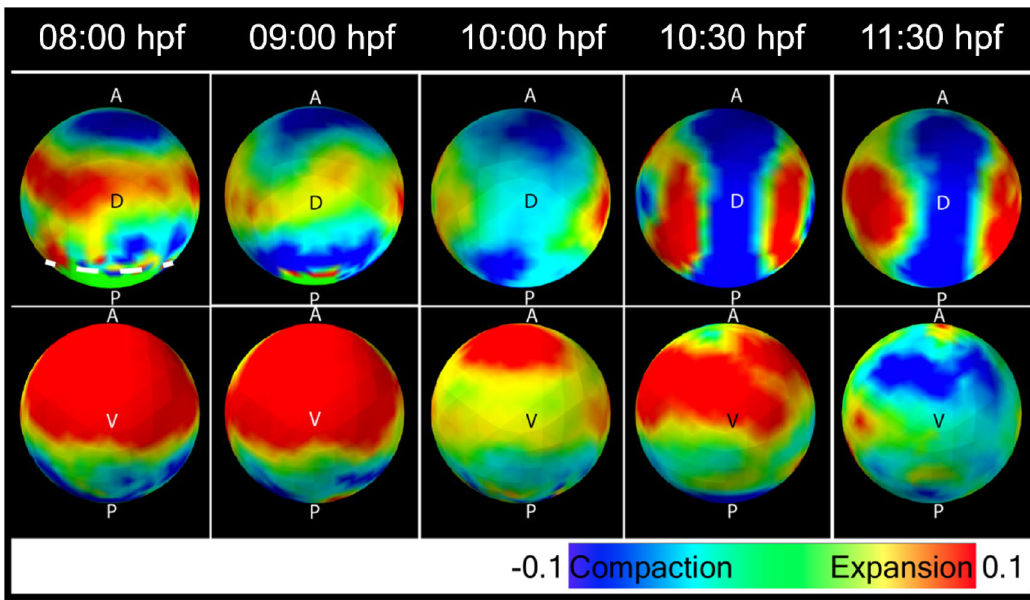
Figure 5. Divergence of velocity field (strain trace) at 8 (80% epiboly), 9 (90% epiboly), 10 (bud, 100% epiboly), 10.5 hpf (1-somite) and at 11:30 hpf. The white dotted line in the posterior side before 100% epiboly, indicates the margin of dorsal closure.